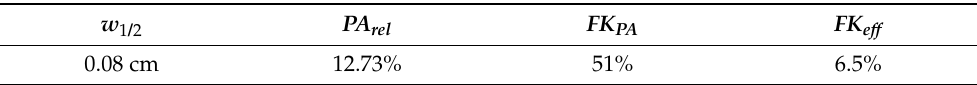
Table 5. Calculated values of treatment efficacy parameters after 60 min of treatment using an IP injection in drug delivery, which employed 100 nm magnetic nanoparticles.